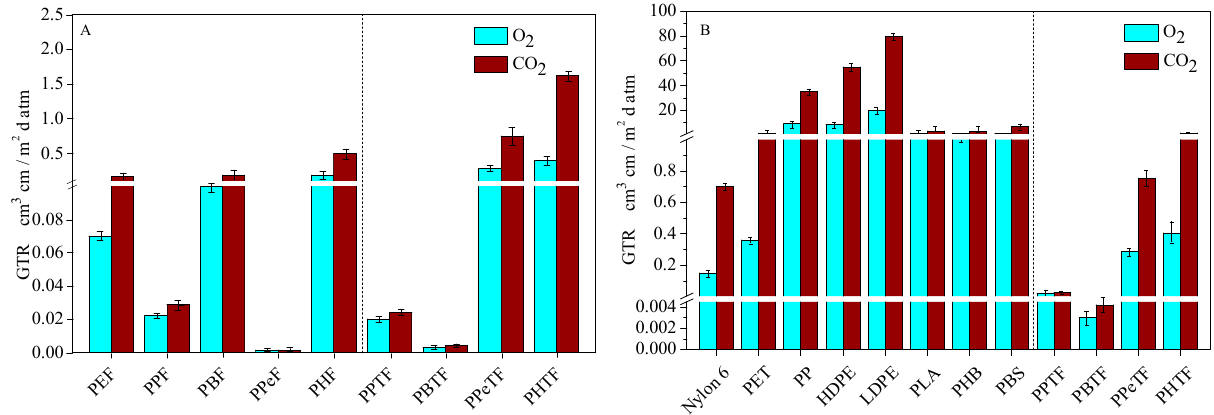
Figure 9. GTR values of O 2 and CO 2 through polymeric films ( T = 23 °C) compared with those of ( A ) furan-based homopolymers [29,33]; ( B ) traditional plastics and principal bio-based polymers [8,18,45].